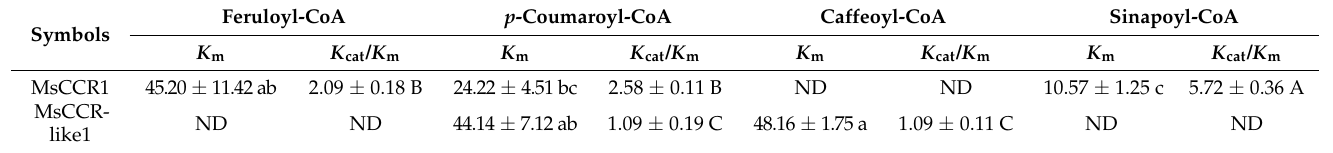
Table 1. Kinetic analysis of MsCCR1 and MsCCR-like1.